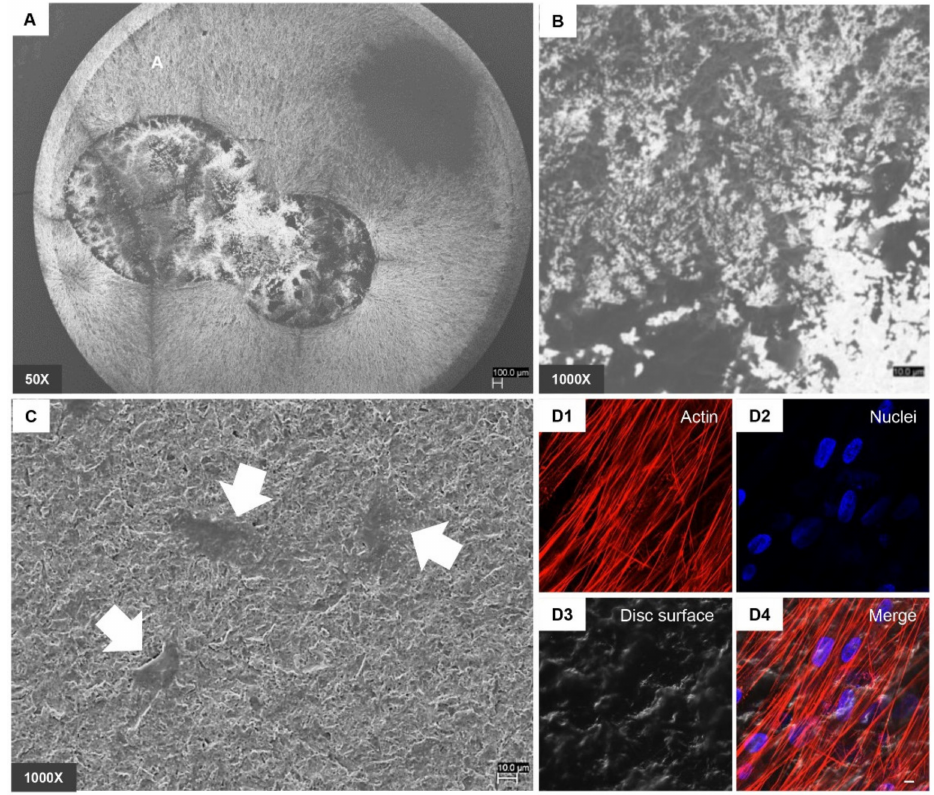
Figure 2. ( A ) SEM observations of CTRL surface without cells captured at 50 × magnification. ( B ) SEM observations of CTRL surface without cells captured at 1000 × magnification. ( C ) SEM observations of hPDLSCs cultured on CTRL surface captured at 1000 × magnification. ( D1 – D4 ) CLSM observation of hPDLSCs cultured on CTRL surface. ( D1 ) Cytoskeleton actin stained with Alexa Fluor 594 phalloidin and observed under red fluorescence channel; ( D2 ) Nuclei stained with TOPRO and observed under blue fluorescence channel; ( D3 ) CTRL surface observed under light transmission channel; ( D4 ) merged image of above mentioned channels. Scale bar: 20 µ m. White arrows indicate adherent cells on CTRL